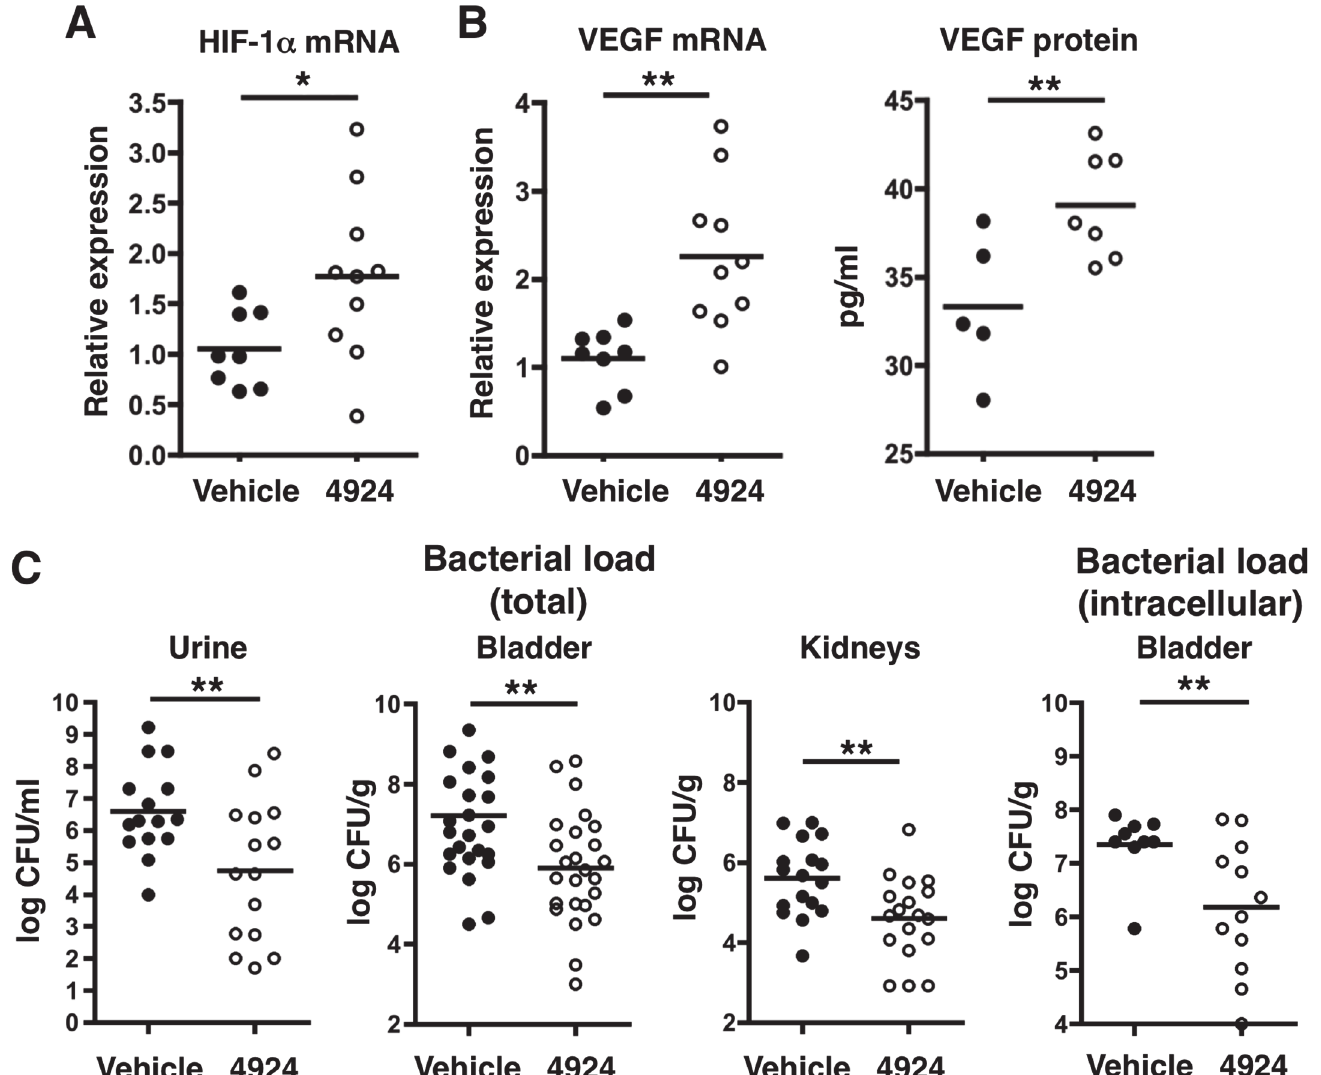
Fig 3. Pretreatment with AKB-4924 impairs UPEC urinary tract colonization in C57BL/6 mice. ( A ) Bladders from female C57BL/6 mice treated with 1 h vehicle, or 0.2 mg/mL AKB-4924, were recovered after 18 – 24 h UPEC CFT073 infection. Real-time qPCR shows increased Hif-1 mRNA in AKB-4924 treated animals. ( B ) Real-time qPCR and ELISA show increased VEGF mRNA and protein expression in AKB-4924 treated group. Data are generated from two independent repeats (n > 5 per experiment). ( C ) UPEC recoveries from urine (n = 15), bladder (n = 25) and both kidneys (n = 18) of mice that received 1 h of 4924 pre-treatment were significantly decreased compared to vehicle treated mice. Data is presented as mean +/- SEM, generated from 3 – 4 independent experiments, ** P < 0.01. Ex vivo gentamicin protection assay revealed intracellular bacterial CFU from mice 18 h post-infection (n = 10,12) doi:10.1371/journal.ppat.1004818.g003 18 – 24 h post-infection; AKB-4924 treatment reduced bacterial recovery from kidneys ( Fig 3C ), indicating that AKB-4924 impedes ascending UTI. One of the key events during UPEC in- fection is intracellular invasion of uroepithelial cells, upon which time the bacteria rapidly de- velop into intracellular bacterial communities (IBCs) [12]. To determine whether AKB-4924 prevents UPEC invasion into the bladder tissue, we treated bladders ex vivo with gentamicin to kill extracellular UPEC to assess level of intracellular bacteria within the tissue. Consistent with the total CFU recovered from the bladder and the in vitro gentamicin protection assay ( Fig 1B ), we found significantly less intracellular (gentamicin-protected) bacteria in the bladder of